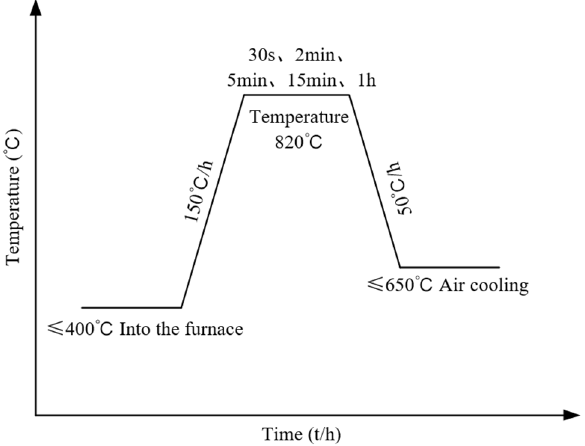
Figure 9. Flow chart of heat treatment with different holding time .